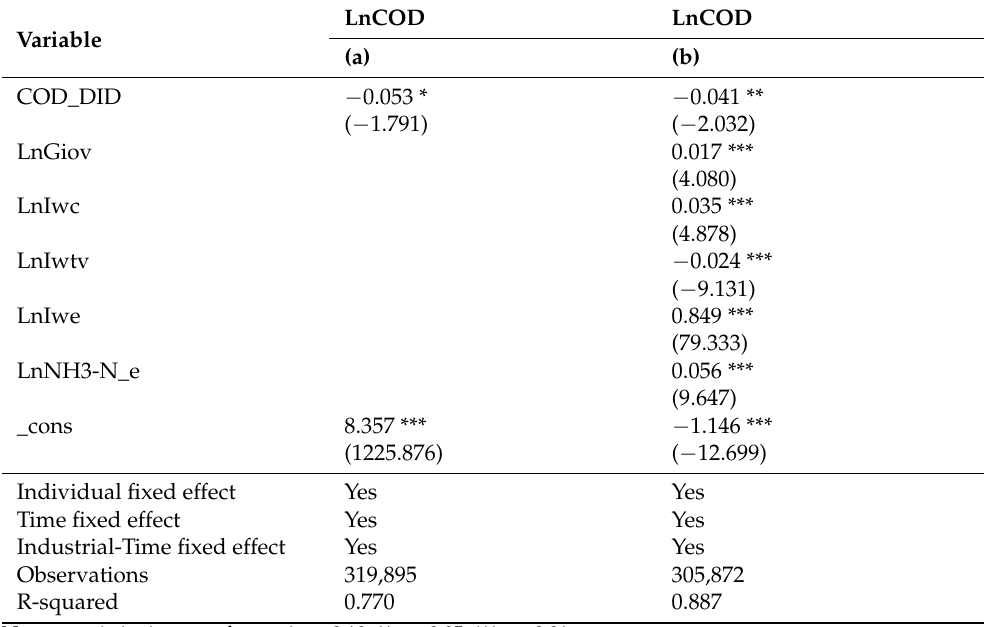
Table 3. Benchmark